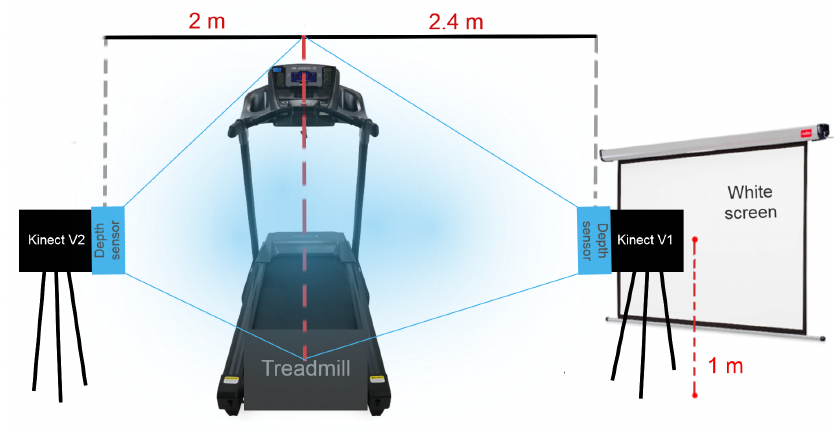
Figure 10. Motion capture system space setup